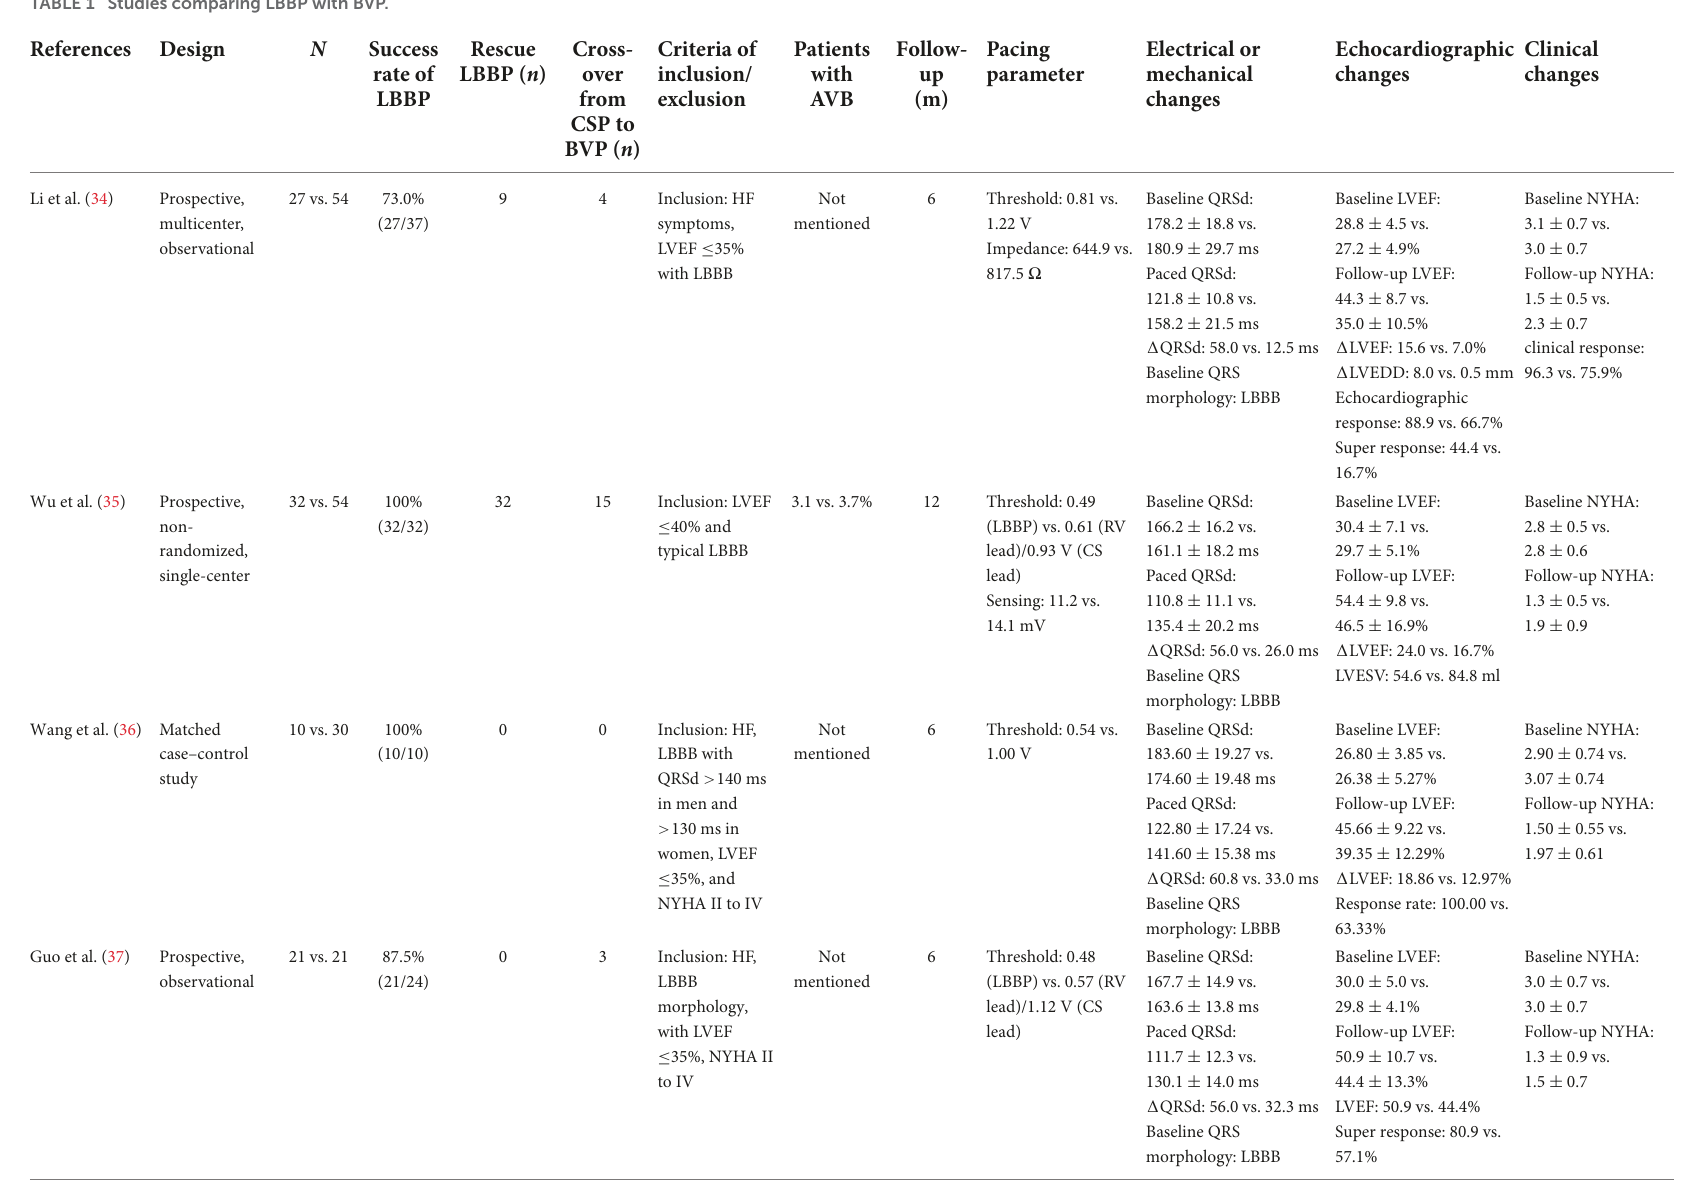
TABLE 1 Studies comparing LBBP with